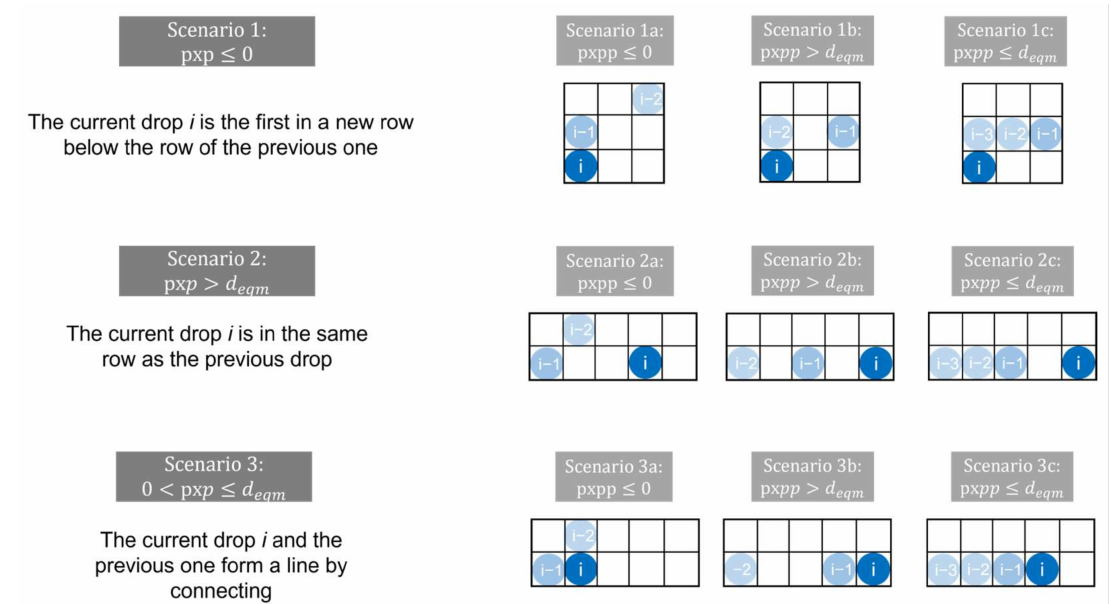
Figure 8. Possible droplet formations depending on the distance to the previous